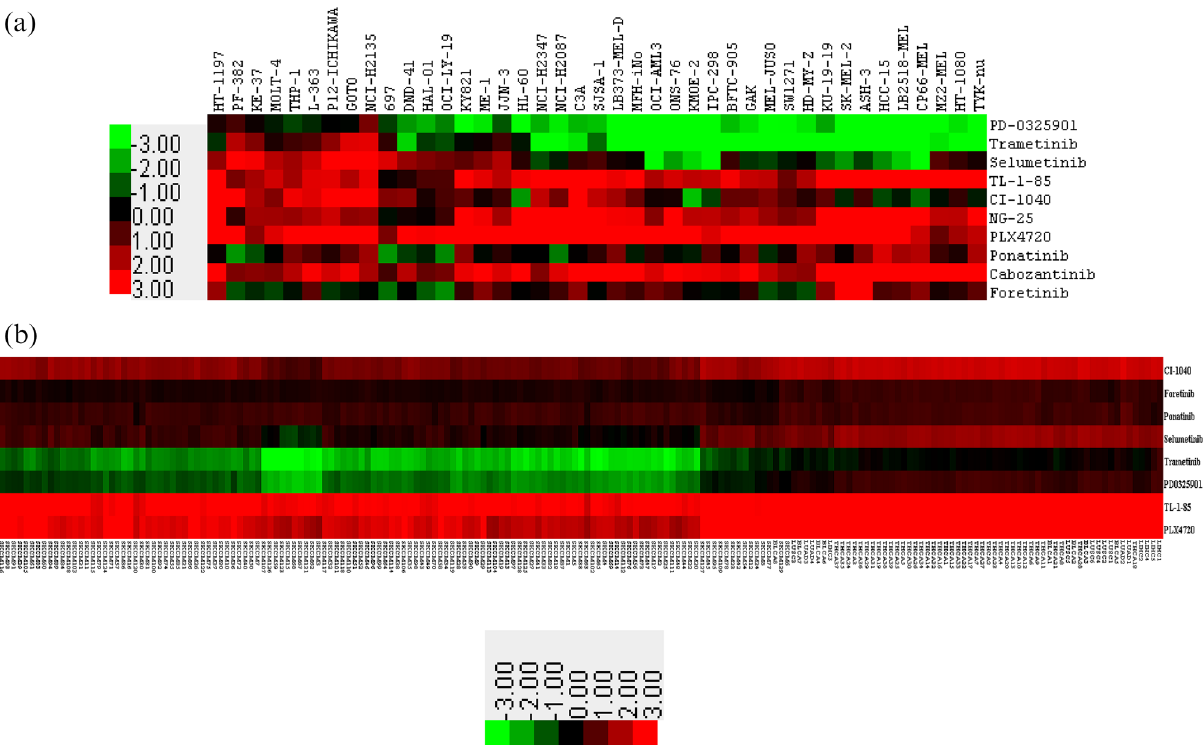
Figure 1. ( a ) Heatmap of drug dose–response in cell lines. Patterns of log normalized drug IC 50 value clustered together. Rows represent drugs and columns represent cell lines. Drug-sensitive cell lines are shown in green and drug-resistant cell lines are shown in red color. ( b ) Heatmap of drug response in cancer tissues. Predicted drug IC 50 value clustered together. Rows represent drugs and columns represent cancer tissue samples from patients. Drug-sensitive cancer tissue samples are shown in green and drug-resistant cancer tissue samples are shown in red